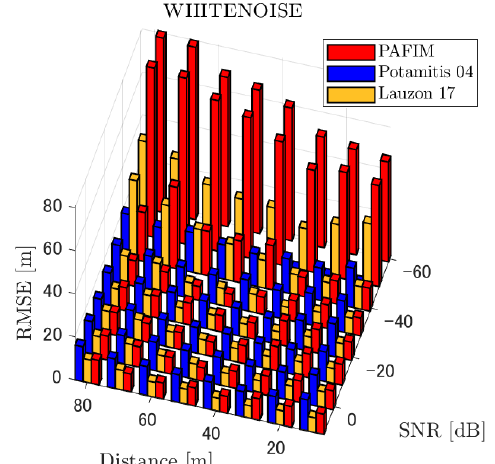
Figure 17. RMSE of tracking a randomly moving sound source emitting white